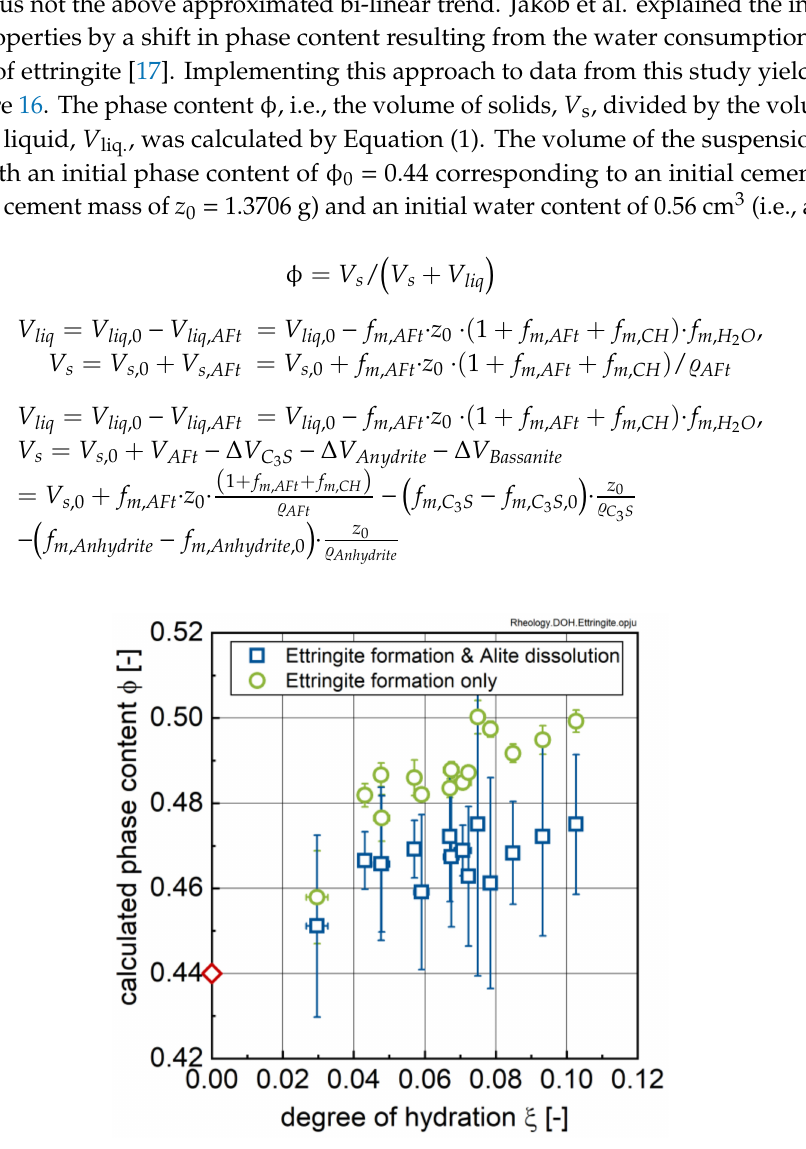
Figure 16. Influence of water absorption due to ettringite formation calculated using Equation (1) and due to combined ettringite formation and alite dissolution calculated from Equation (2),